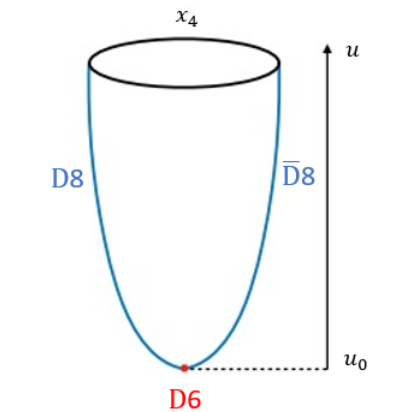
Figure 1 . The displacement of the D-branes on the cigar of the geometry (2.1) for antipodally embedded